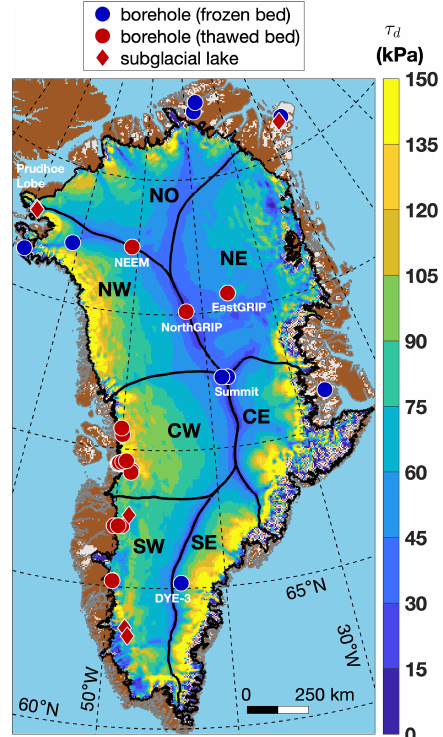
Figure 1. Reference map for the GrIS study area with driving stress overlain (Sect. 2.5) and locations discussed in the text labeled. Ice- drainage basins are outlined and labeled following Mouginot et al. (2019). The reported basal thermal state of boreholes follows M16 and Table 1, except for NEEM and EastGRIP (Sect. 2.1). The four known subglacial lakes included in M16 are shown, along with two additional active subglacial lakes identified by Bowling